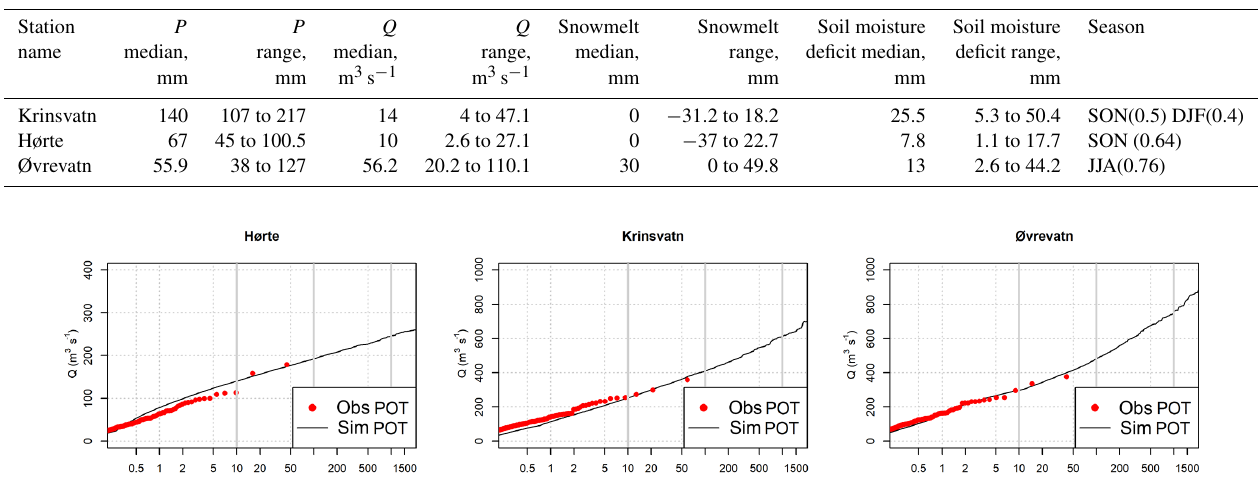
Table 2. Precipitation (48h duration is used for Krinsvatn) and initial conditions for Q 100 ; range corresponds to 5 and 95 percentile. For the seasonality, the actual fraction of the simulated events is given in brackets.